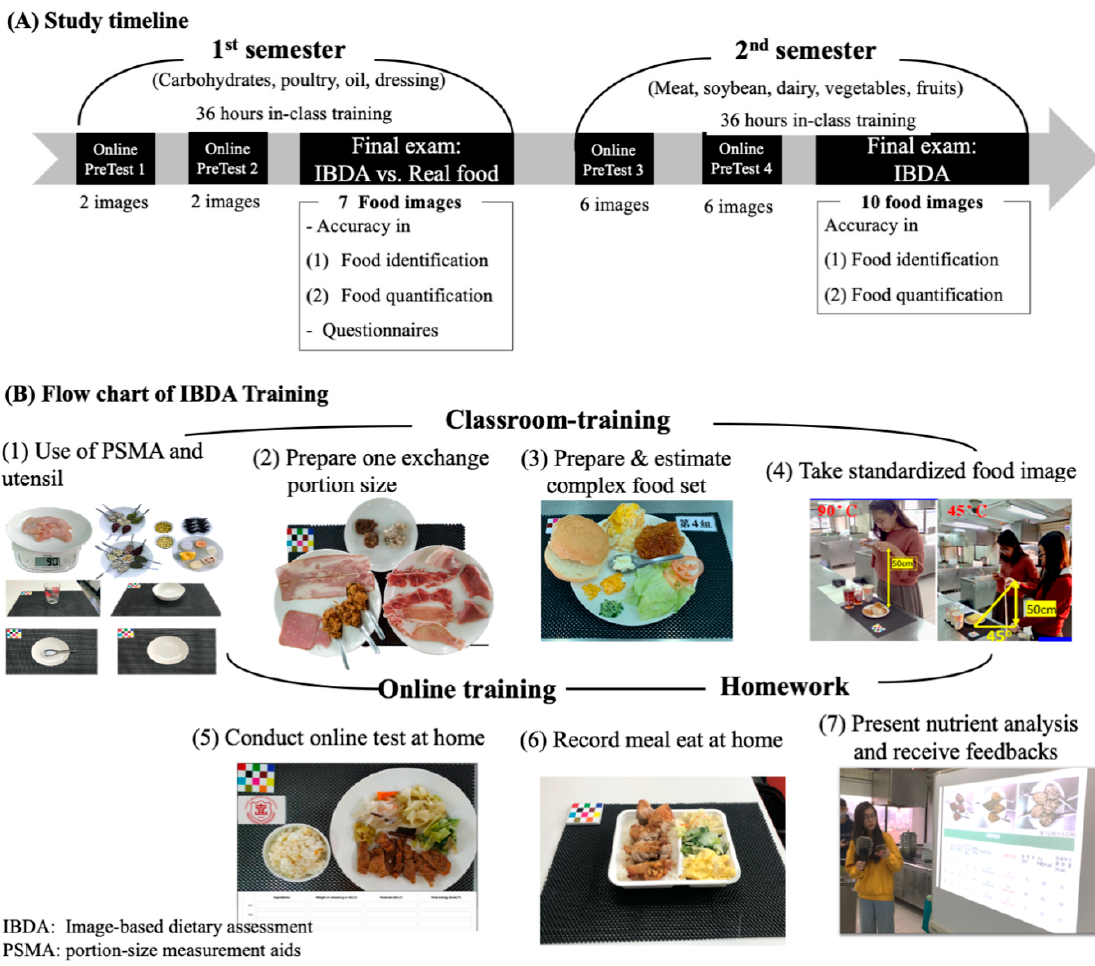
Figure 1. Flowchart and timeline of the integration of the image-based dietary assessment (IBDA) training protocol into the nutrition practicum course. ( A ) Study timeline; ( B ): Flowchart of IBDA training. PSMA: portion-size measurement aids